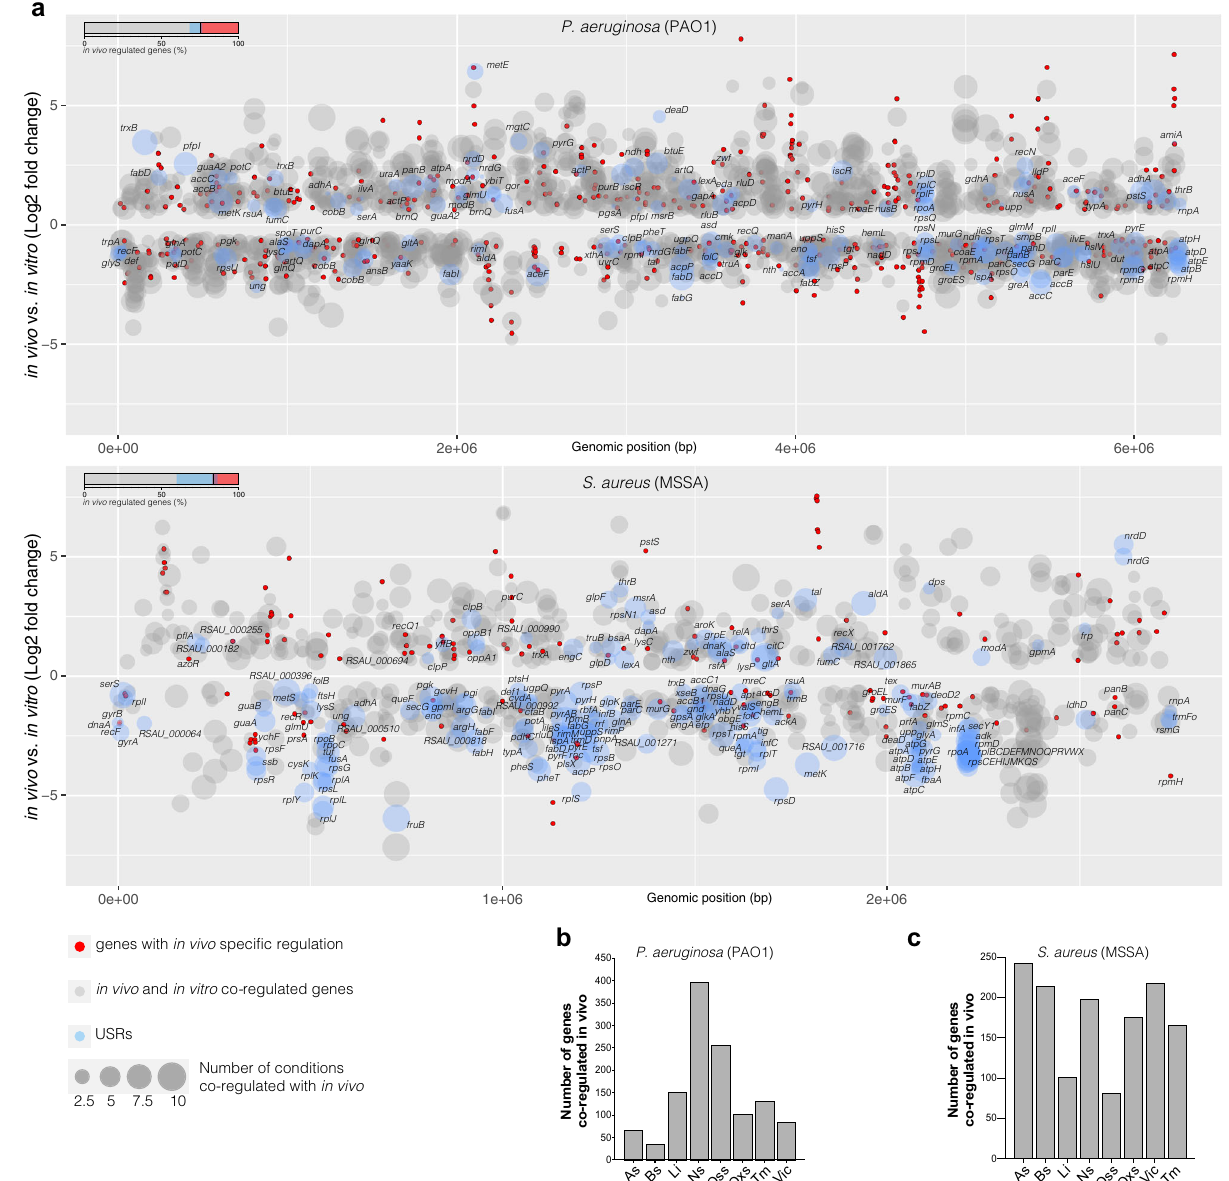
Fig. 4 Stress responses identi fi ed in PATHOgenex are relevant for infection in vivo and can be used for determination of environmental stresses for pathogens at different infection niches. a Differentially expressed genes obtained from differential expression analysis of in vivo transcriptomes of P. aeruginosa in cystic fi brosis lungs 45 and S. aureus (MSSA) during acute murine osteomyelitis 46 were mapped to in vitro stress responses of the corresponding species. Log2 fold changes in vivo vs. in vitro (control) are shown with genomic localization of genes for each species. The genes that are co- regulated (up/up or down/down) between in vivo and in vitro stress conditions are shown in gray or blue (conserved USRs) bubbles where the size of the bubble indicates number of conditions showing co-regulation with in vivo. Genes with in vivo speci fi c regulation, which has no co-regulation at any of the stress conditions, are shown with red bubbles. The bars in the upper left corner of each bubble plot indicate the proportion of genes that are similarly regulated in vivo and in vitro (grey and blue, where blue indicate USRs) and proportion of genes showing in vivo speci fi c regulation (red). b The number of genes that are co-regulated during infection for each of the PATHOgenex in vitro stress conditions for P. aeruginosa and c , for S. aureus . Hypoxia, nutritional downshift, and stationary phase were not included due to the presence of variety of stress responses under those conditions. Source data are provided as a Source Data fi